Question: What direction does the quantity move in — increasing or decreasing?
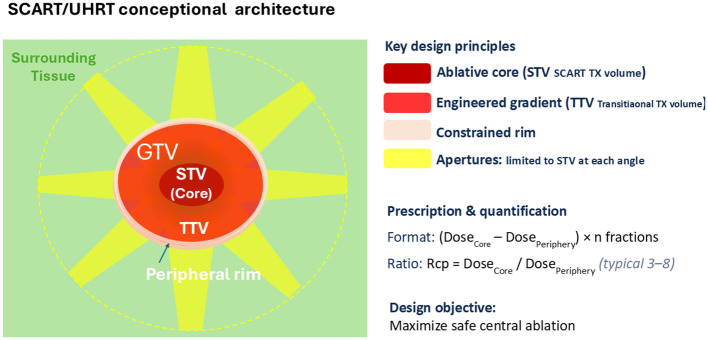
Answer: decreasing